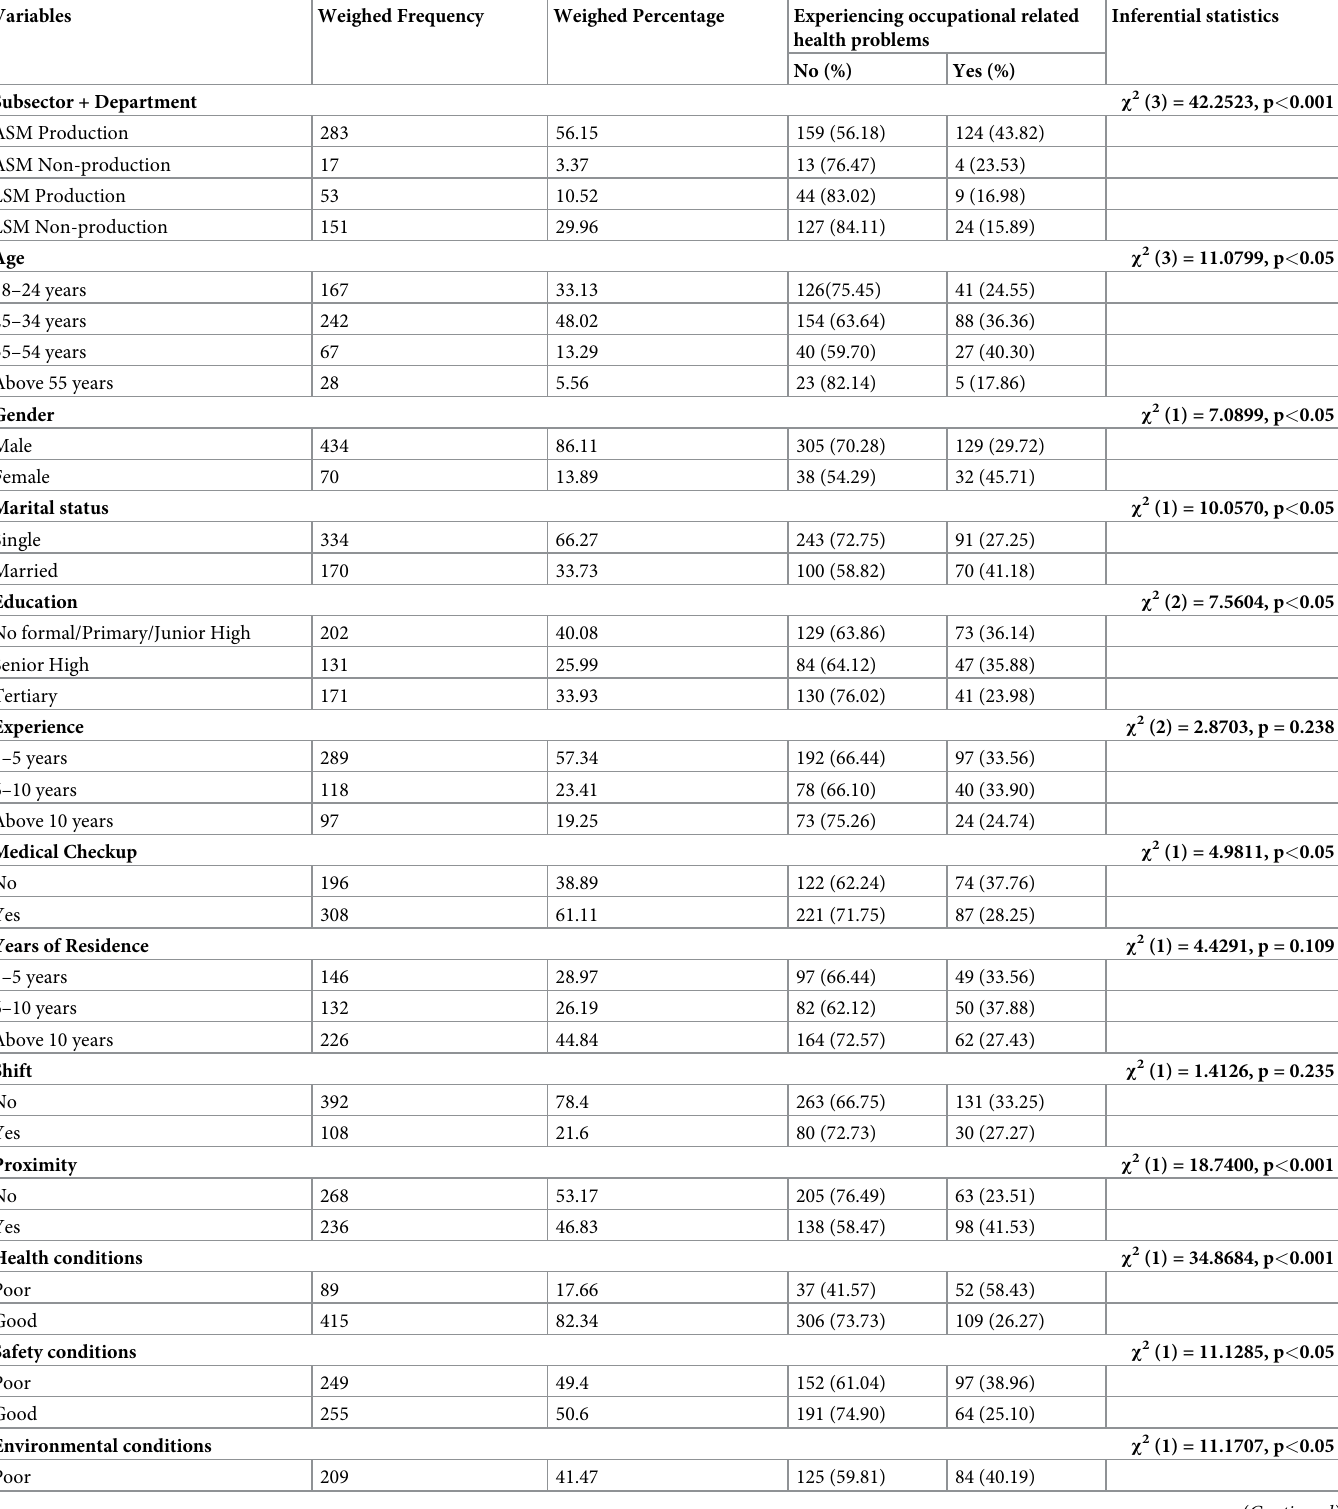
Table 1. Demographic characteristics and percentage distribution of experiencing occupational related health problems by predictor